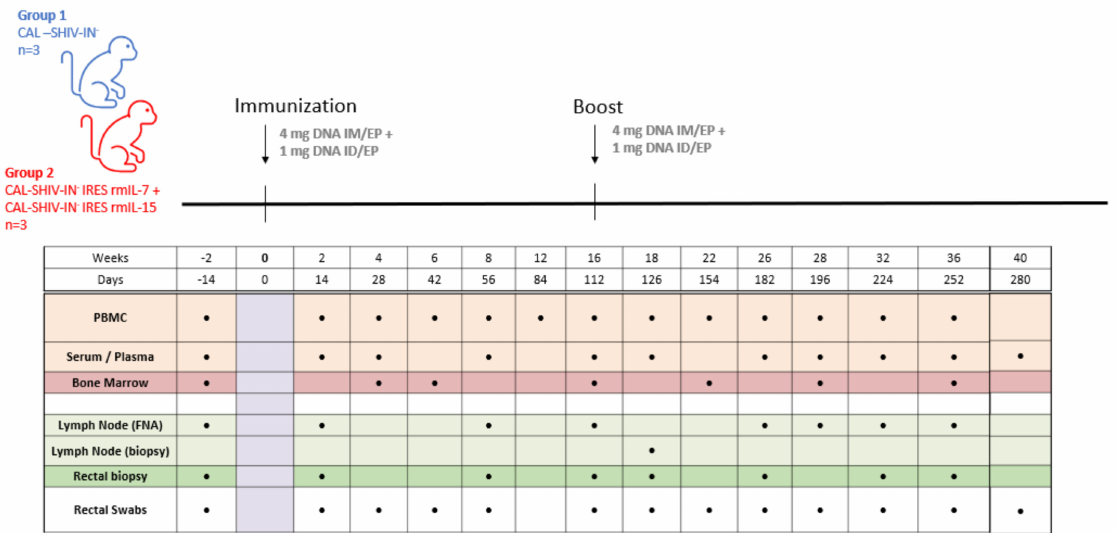
Figure A4. Immunization and sampling of vaccinated macaques: Three macaques per group were immunized with the CAL-SHIV-IN − vaccine (group 1) or co-immunized with the CAL-SHIV-IN − IRES IL-7 and CAL-SHIV-IN − IRES IL-15 (group 2) by ID/EP and IM/EP. Homologous vaccination booster was administered 16 weeks later. Different samples were harvested to monitor and evaluate the immune responses up to 40